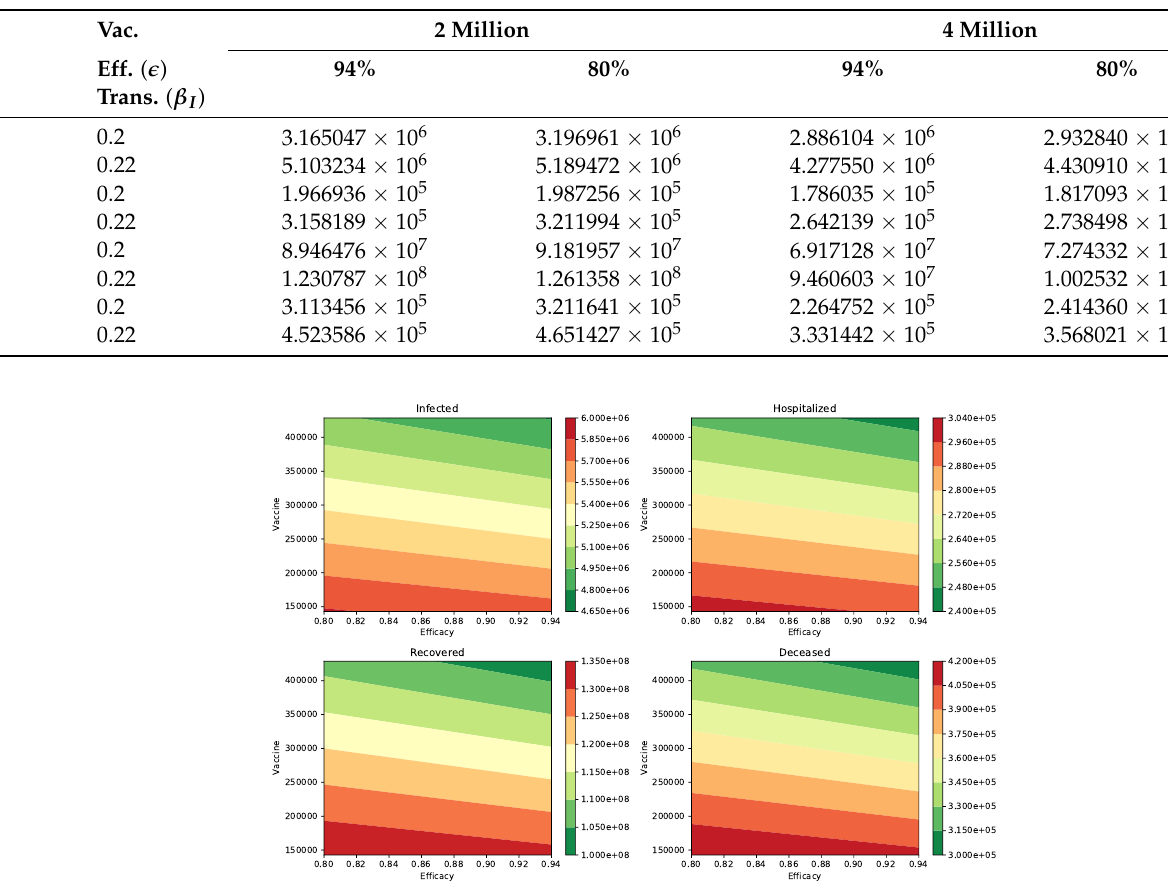
Figure 2. Impact of the inoculation rate and efficacy of the vaccine on the peak of the infected (I) and hospitalized (H) subpopulations. In addition, on the deaths (D) and recovered (R) cases. In these scenarios, the infectiousness of the asymptomatic individuals relative to symptomatic is 100% ( β A = β I ), and the percentage of infections that are asymptomatic is 50%. In all these scenarios the transmission rate is β =